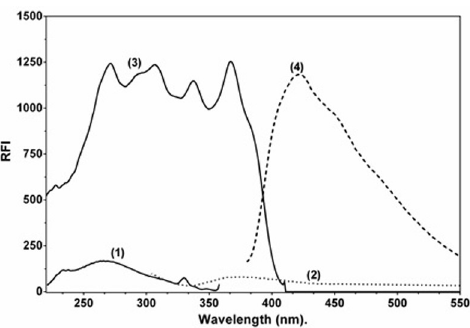
Fig 2. Fluorescence spectra of LAP (1000 ng/mL) and its interaction mixture with kolliphor RH 40 (2%, w/v). Spectra (1) and (2) are the excitation and emission (respectively) of LAP aqueous solution in absence of kolliphor RH 40. Spectra (3) and (4) are the excitation and emission (respectively) of LAP aqueous solution containing kolliphor RH